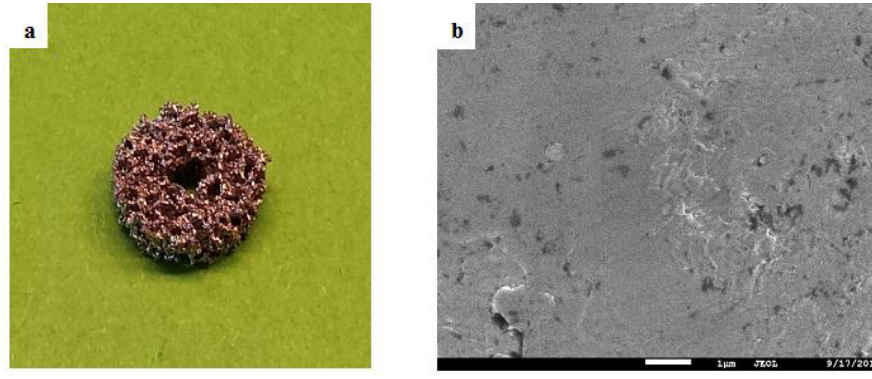
Figure 1. ( a ) Macrograph of test sample and ( b ) SEM micrograph of AsM surface.